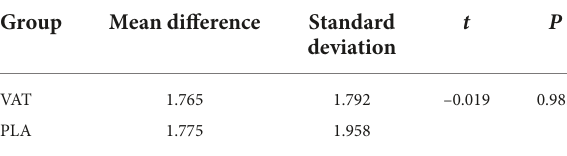
TABLE 5 Between groups difference for pre and post-test differences of VAS-S (VAS-S, visual analogue scale for stress; VAT, vibroacoustic therapy; PLA,